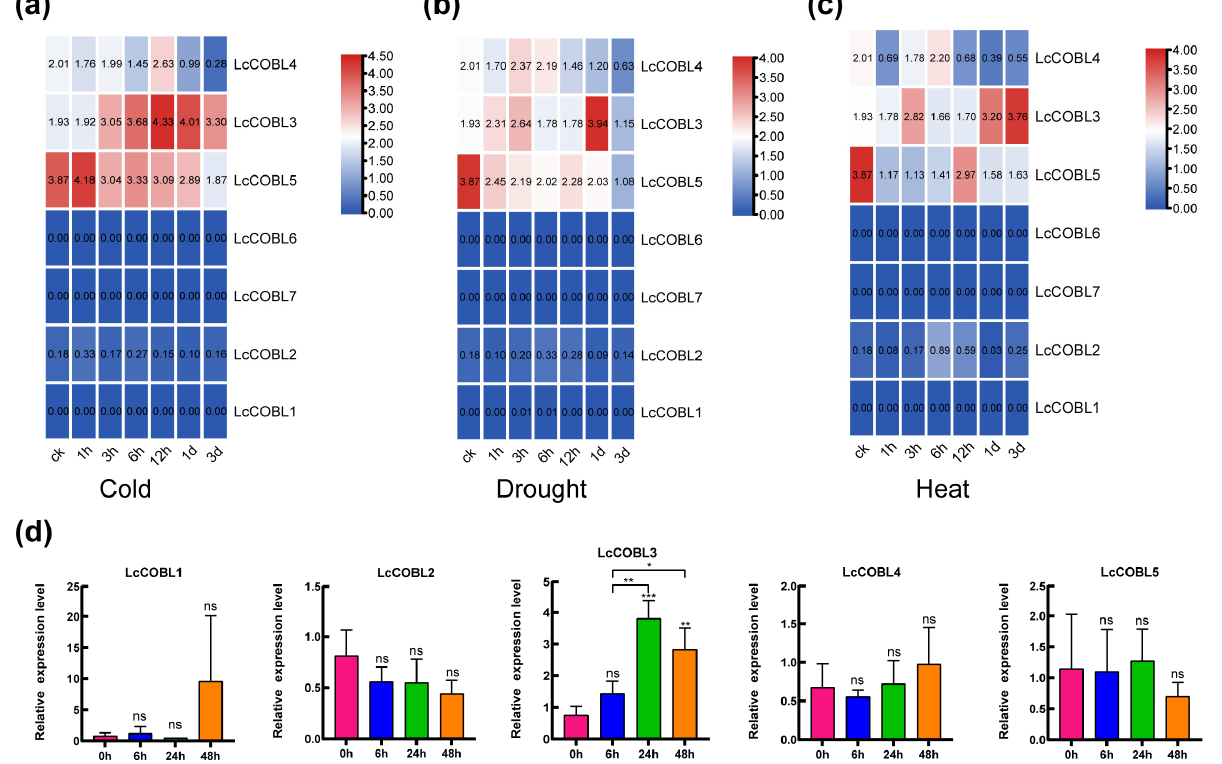
Figure 7. Subcellular localization of LcCOBL5 protein in L. chinense calli ( a ) and onion epidermal cells ( b ). In these pictures, GFP indicates green fluorescence photography, bright field indicates bright-field photography, RFP indicates red fluorescence photography and merged indicates the fusion of green fluorescence, red fluorescence and bright field photography. The red fluorescence locates the nucleus, and the green fluorescence locates the LcCOBL proteins.